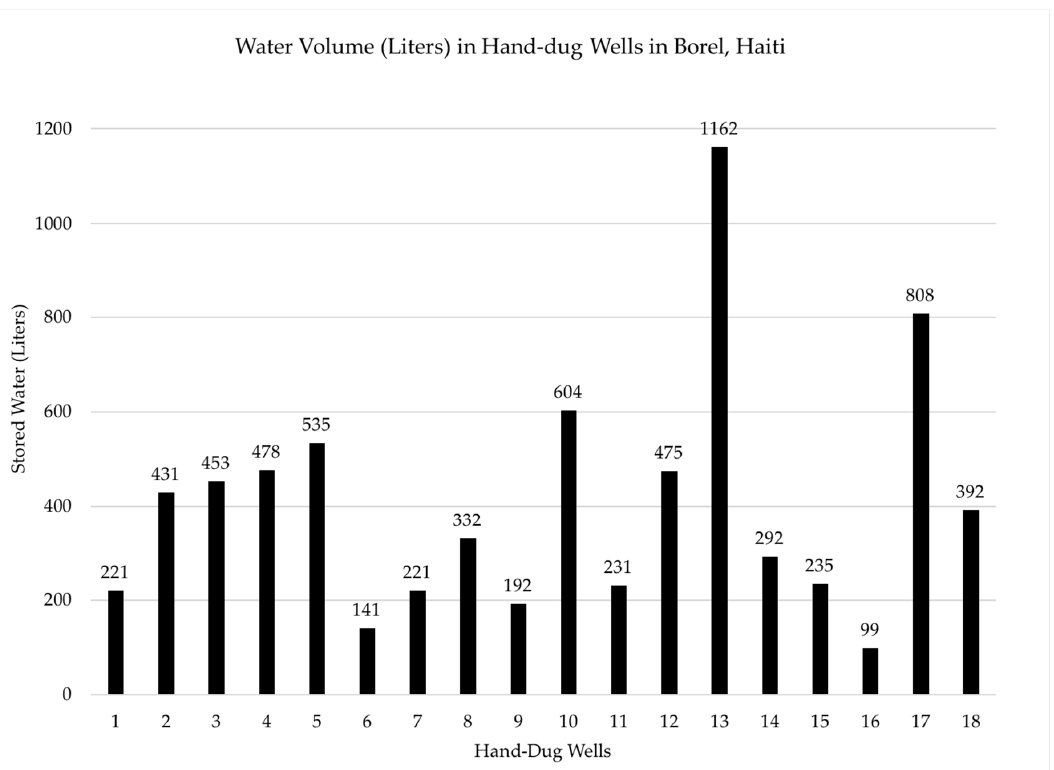
Figure 7. Hand–dug well water volume data. Table 1. Hand–dug well bacterial water quality data.